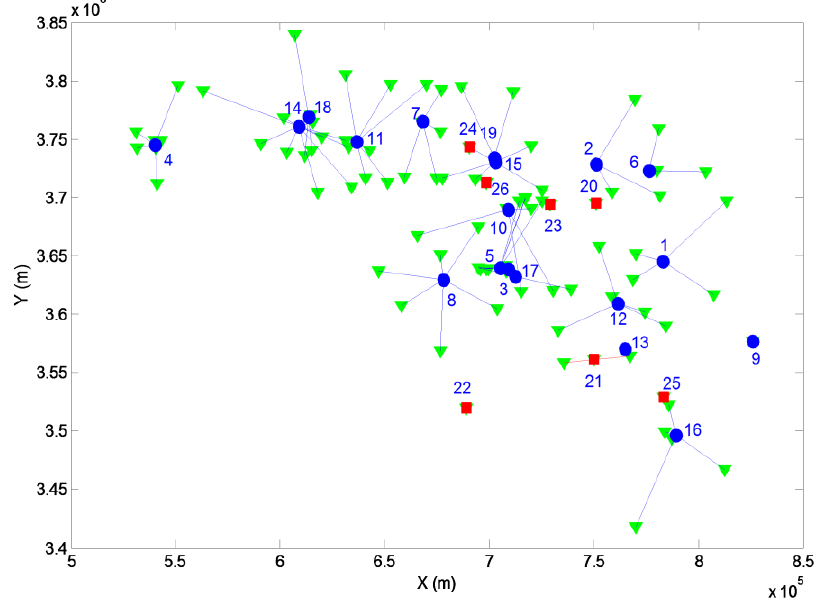
Figure 5. Results of applying GA to solve SEP problem on a real